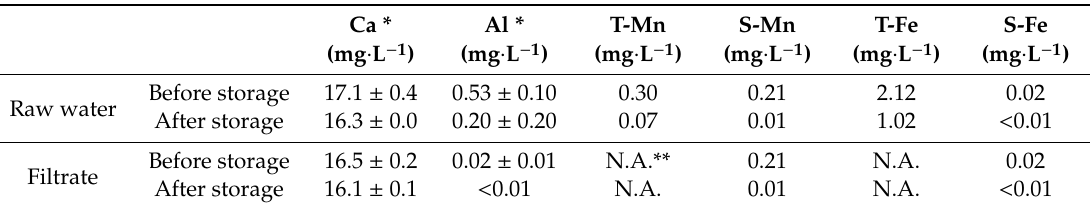
Table 4. Inorganic contents in raw water and filtrate (March